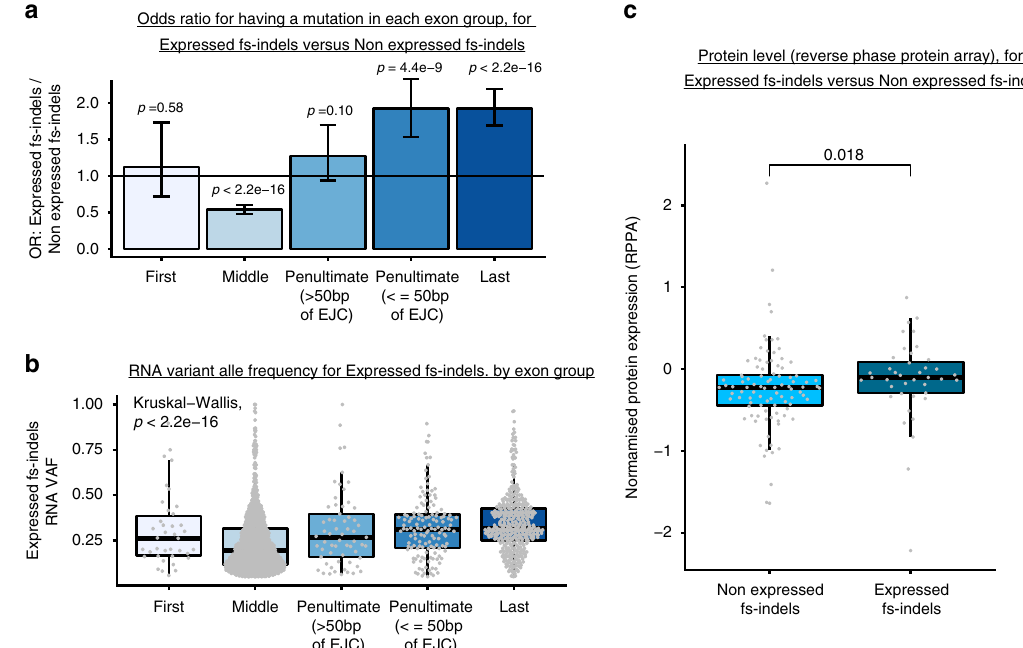
Fig. 2 Expressed fs-indels follow the rules of NMD. a Shows the odds ratio (OR), between expressed fs-indels and non-expressed fs-indels, for falling into either fi rst, middle, penultimate or last exon positions. Odds ratios and associated p -values were calculated using Fisher ’ s Exact Test. Data is from n = 453 TCGA patients, and statistics are based on n = 13,420 mutations. Coloring is used arbitrarily to distinguish groups. The measure of centre is the odds ratio value and error bars denote 95% con fi dence intervals of OR estimates. b Shows variant allele frequencies for expressed fs-indels by exon group position. Kruskal – Wallis test was used to test for a difference in distribution between groups. Data is from n = 453 TCGA patients. c Shows protein expression levels for not expressed, versus expressed, fs-indel mutations. Two-sided Mann – Whitney U test was used to assess for a difference between groups. Data is based on n = 136 mutations. In all boxplots in this fi gure the centre line is the median, the bounds of the box represent the inter-quartile range, the lower whisker = max(min(x), Q_1 – 1.5 × IQR) and upper whisker = min(max(x), Q_3 + 1.5 ×